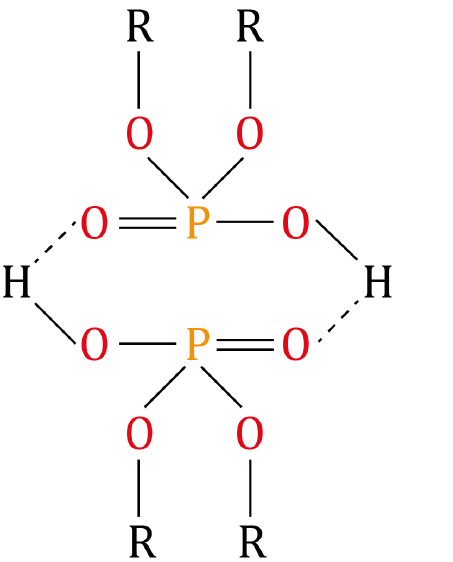
Figure 2. Molecular structure of the extractants used in this study; ( a ) D 2 EHPA , ( b ) Cyanex 572. (Done by the authors).